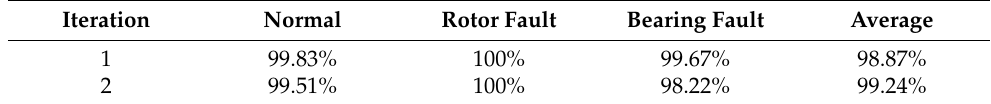
Table 4. Diagnostic accuracy of multilayer neural network for cross-validation. Iteration